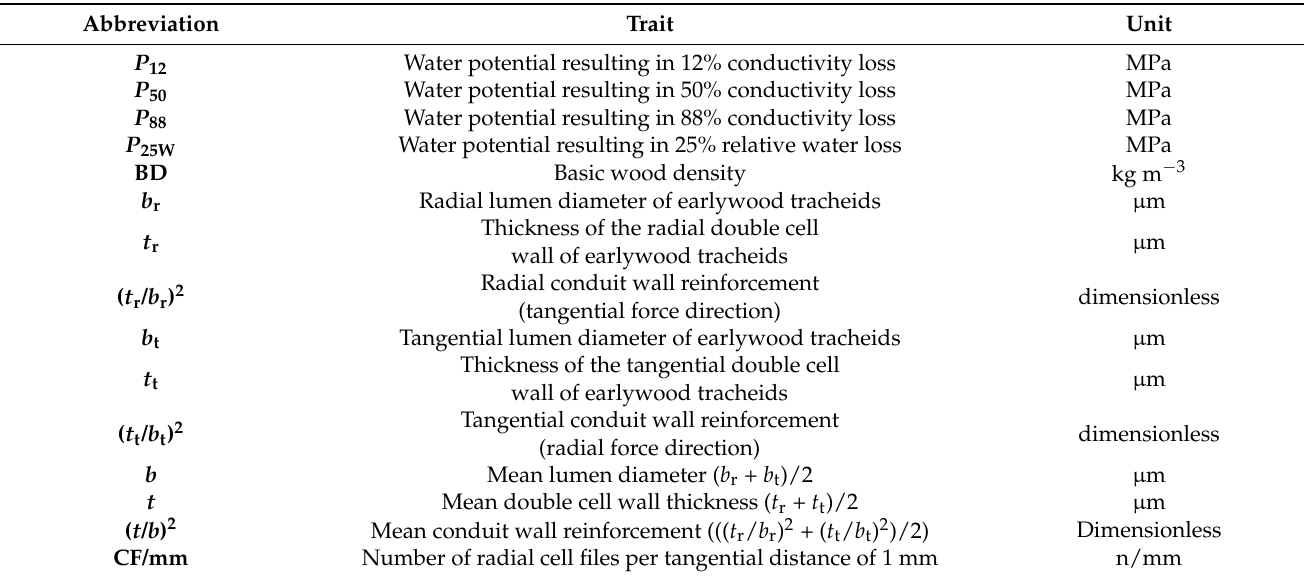
Table 2. List of traits and their abbreviations.